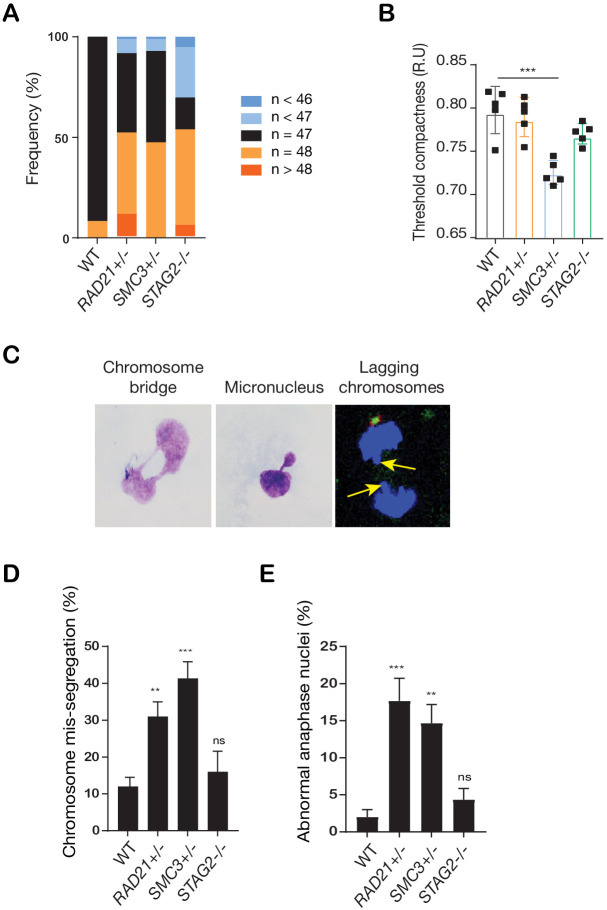
Cohesin deficiency causes a modest increase in chromosome mis-segregation events in MCF10A cells.(A) Frequency of aneuploidy in cohesin-deficient MCF10A clones compared to parental MCF10A (WT). (B) Threshold compactness in the nuclei of cohesin-deficient clones compared to wild type MCF10A (R.U. = relative units). n = 5 independent experiments (square symbols), mean ± s.d., one-way ANOVA: ***p≤0.001. (C) Representative images of abnormal interphase nuclei showing chromosome bridges, micronuclei, and lagging chromosomes at anaphase. (D) Quantification of chromosome bridges and micronuclei events in MCF10A cohesin-deficient cells. (E) Quantification of chromosome mis-segregation observed in MCF10A cohesin-deficient clones. At least 100 mitotic cells were examined per condition, n = 3 independent experiments, mean ±s.d., one-way ANOVA **p≤0.01; ***p≤0.0005; ns, not significant.